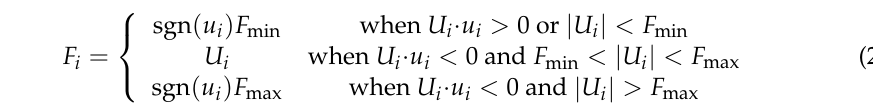
Figure 7. The L-shaped frame structure has ten floors with a total height of 34.5 m.